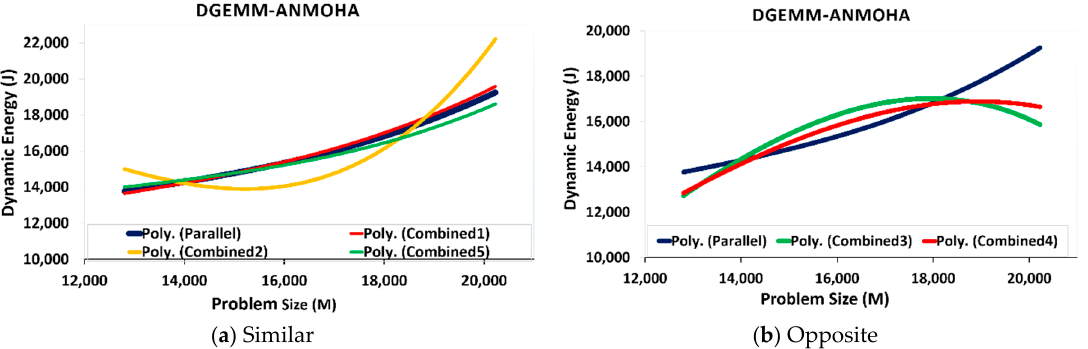
Figure 4. Regression models of energy profiles in set of energy profiles (EPS) DGEMM_AnMoHA. ( a ) Combined_1 and Combined_5 follows the same trend, Combined_2 follows similar trend, and ( b ) all profiles exhibit opposite trend as of the ground truth. Here, DGEMM refers to Double-precision General Matrix Multiplication application, and AnMoHA refers to Additive Energy Modelling of Hybrid Applications.